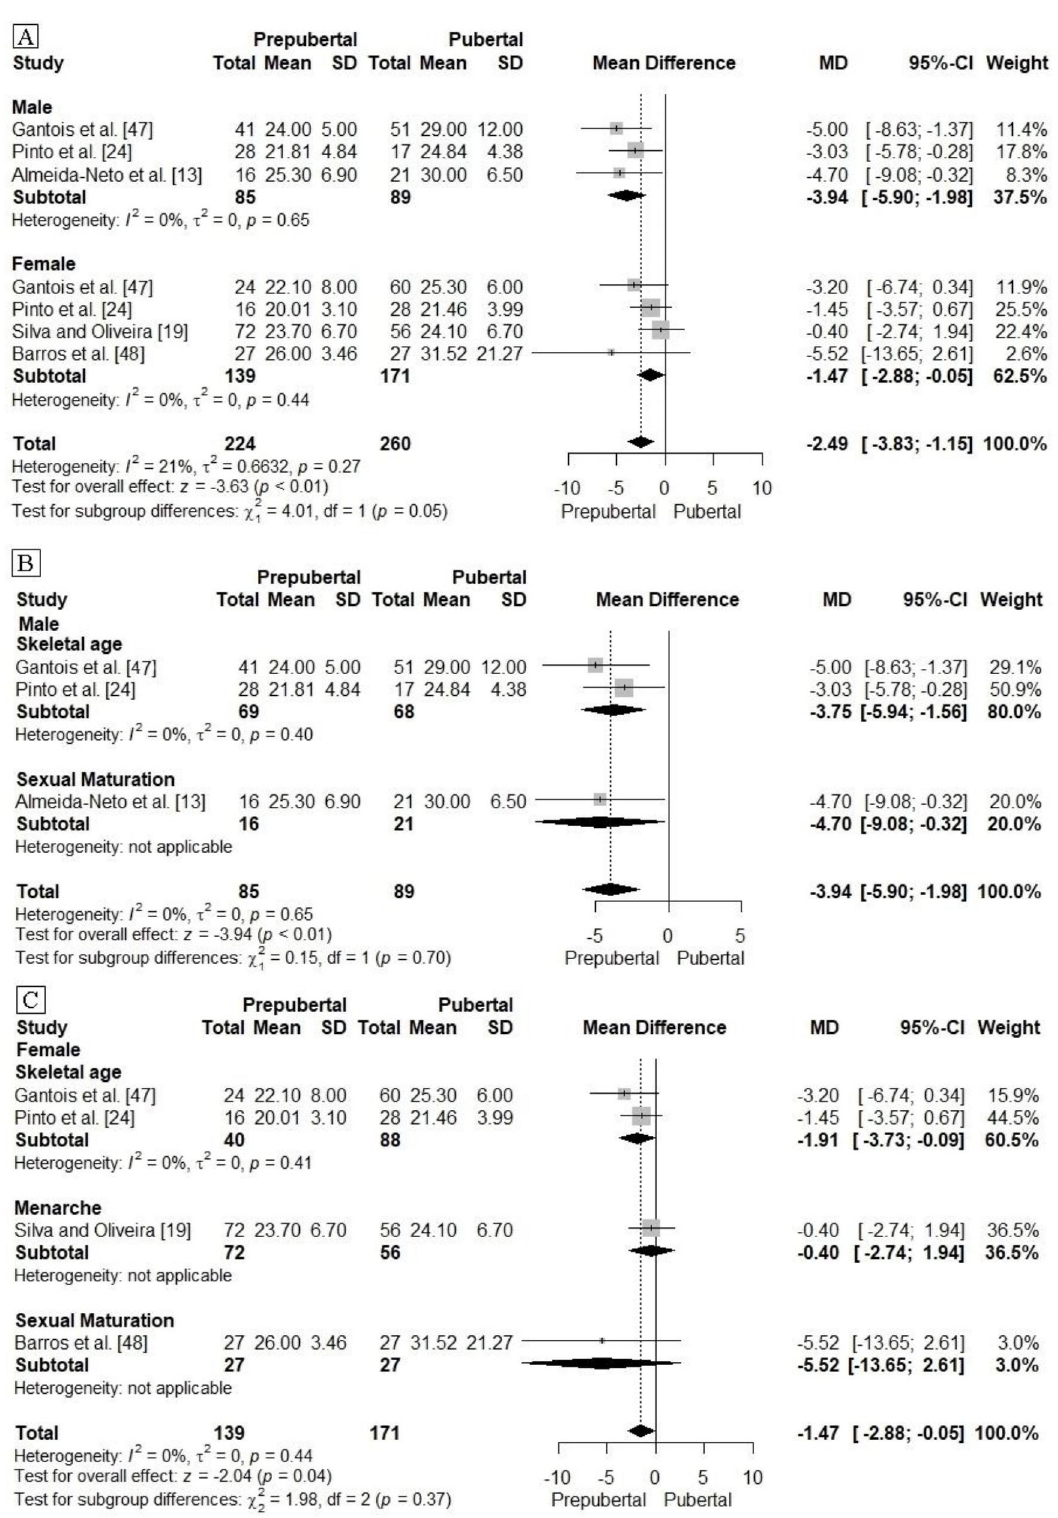
Fig 5. Meta-analysis grouping the studies by stage of biological maturation [prepubertal and pubertal]. SJ:Squat jump. CMJ: Countermovement jump. SD: Standard deviation. MD: Mean Difference.